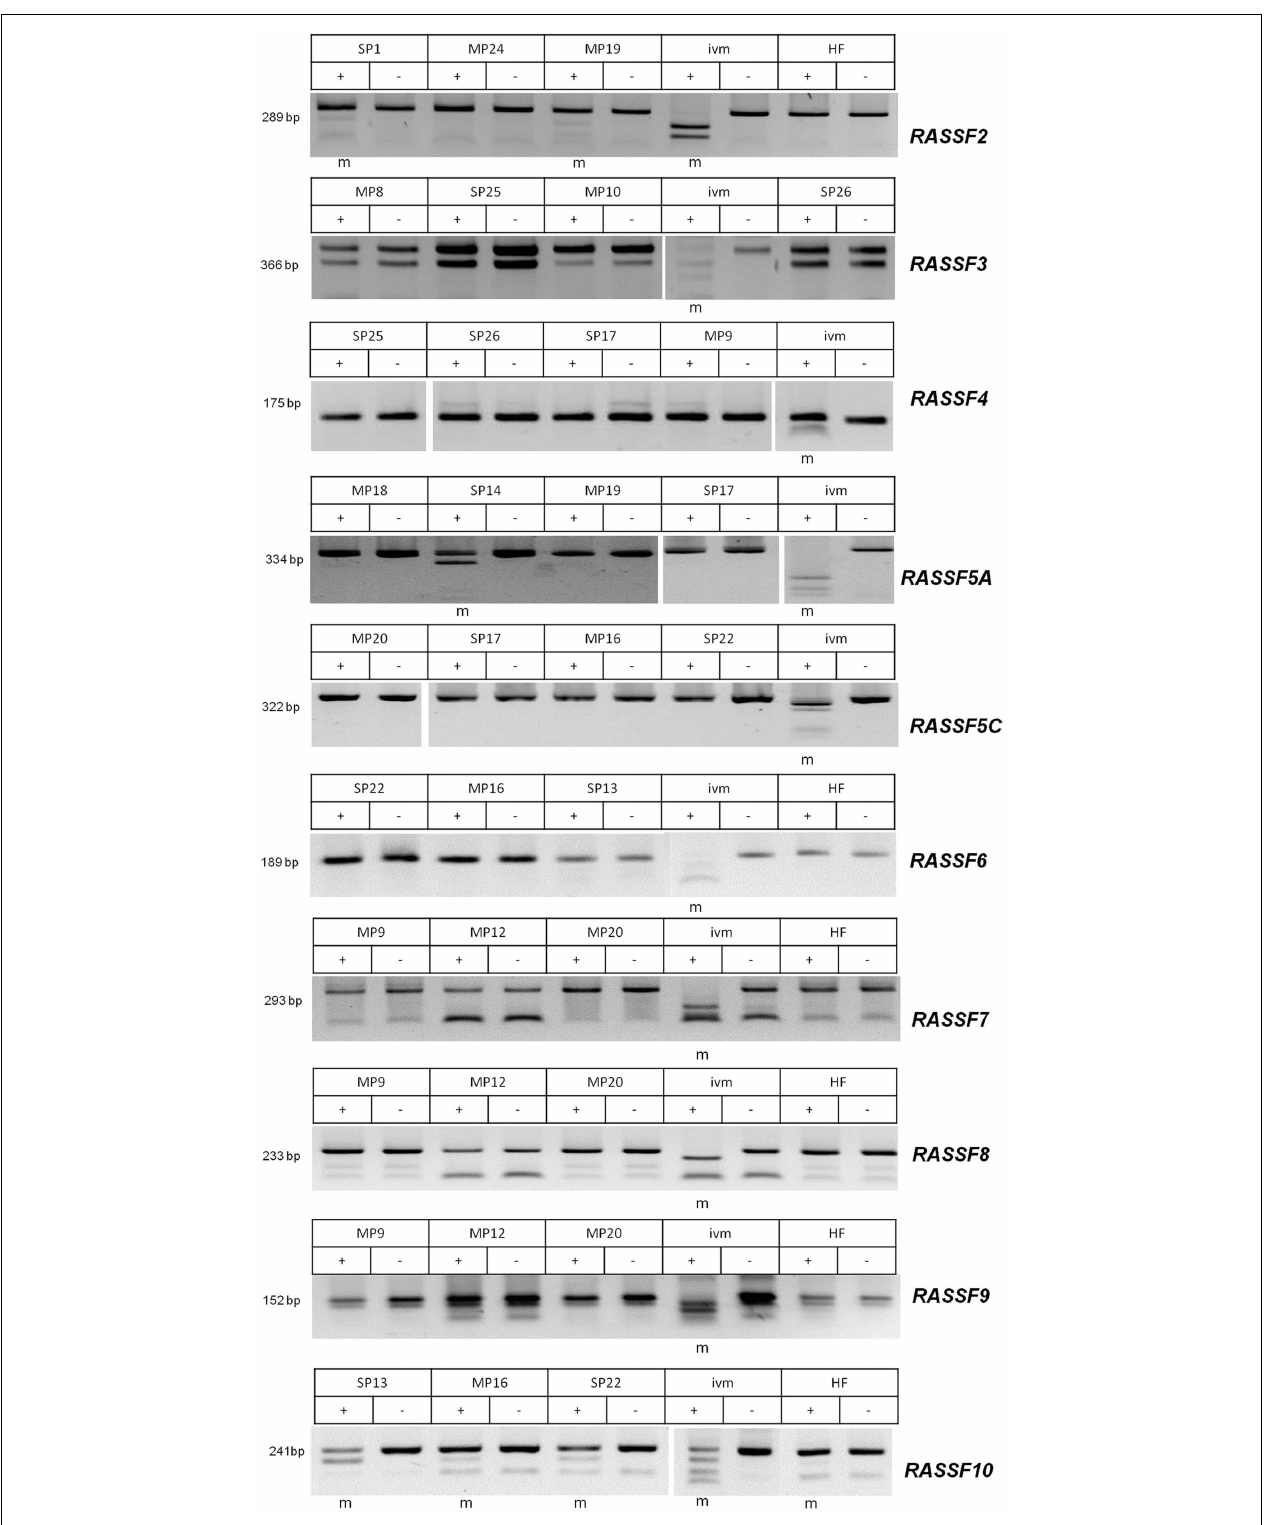
( + ) or mock digested ( − ). Sporadic (SP) and hereditary (MP) PCCs are exemplarily shown for each RASSF together with in vitro methylated ( ivm ) positive control sample and human fibroblasts (HF) as normal cell control. Methylated samples are marked (m) below each